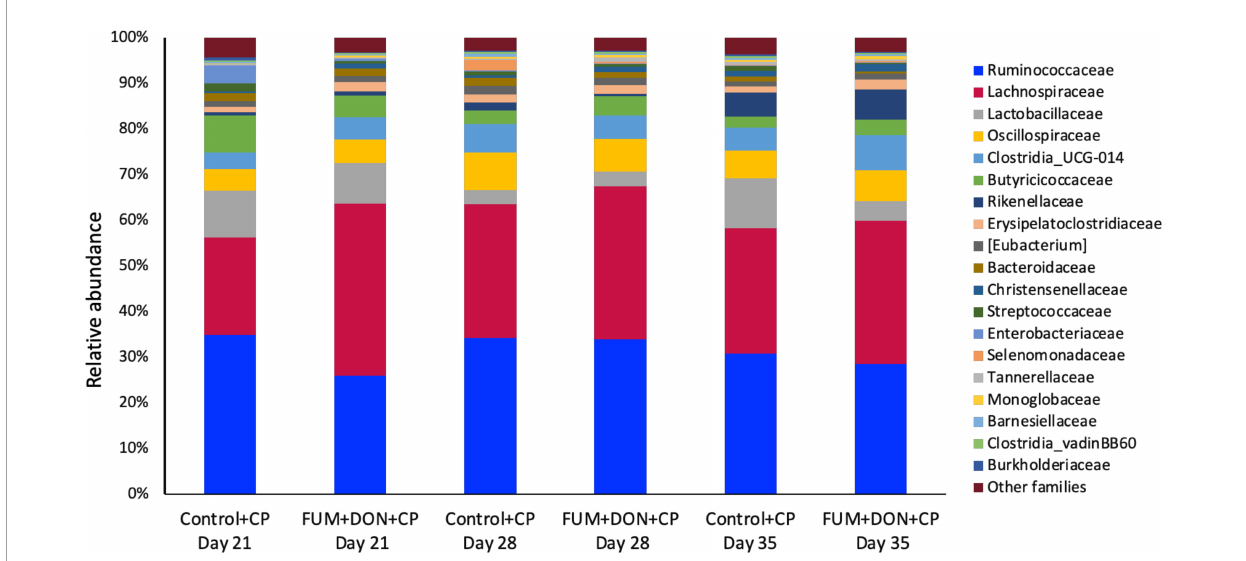
FIGURE4 Relative abundance of microbiome at the family level. Broilers were fed control or mycotoxin (FUM 3 mg/kg diet + DON 4 mg/kg diet). All birds received 1 × 10 8 CFU/bird of C. perfringens on d 19 and 20. Cecal digesta was analyzed for relative abundance of microbiome using 16S rRNA sequencing at 1, 7, and 14 days post-infection.